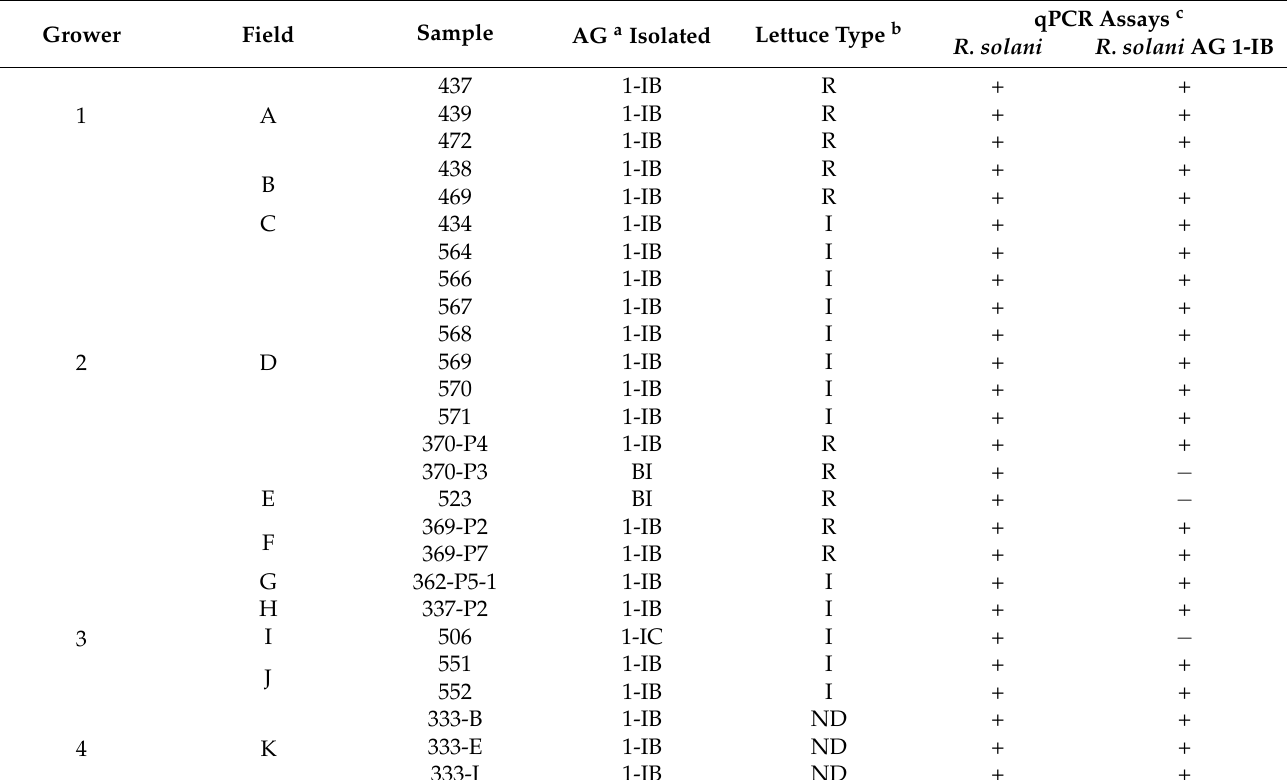
Table 3. Validation of the detection of Rhizoctonia solani and Rhizoctonia solani AG1-IB in field lettuce samples presenting bottom rot symptoms by molecular assay with qPCR for which R. solani isolates were identified by culture method.